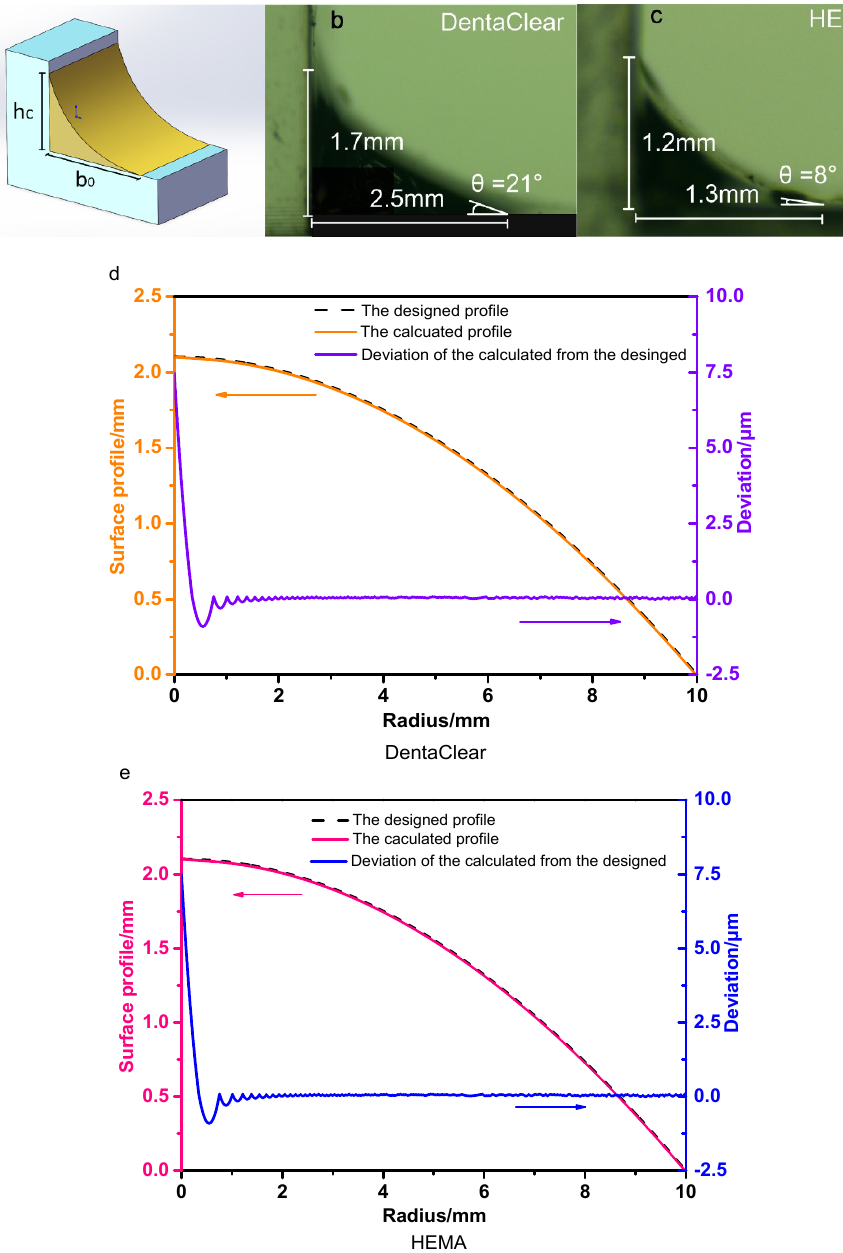
Figure 4. ( a ) Illustration of meniscus wetting to intersecting plane surfaces. ( b ) Built part for measuring the surface tension parameters of DentaClear. ( c ) Built part for measuring the surface tension parameters of HEMA. ( d ) Calculated surface profile and deviation of DentaClear lenses compared to the designed curve. ( e ) Calculated surface profile and deviation of HEMA lenses compared to the designed curve.